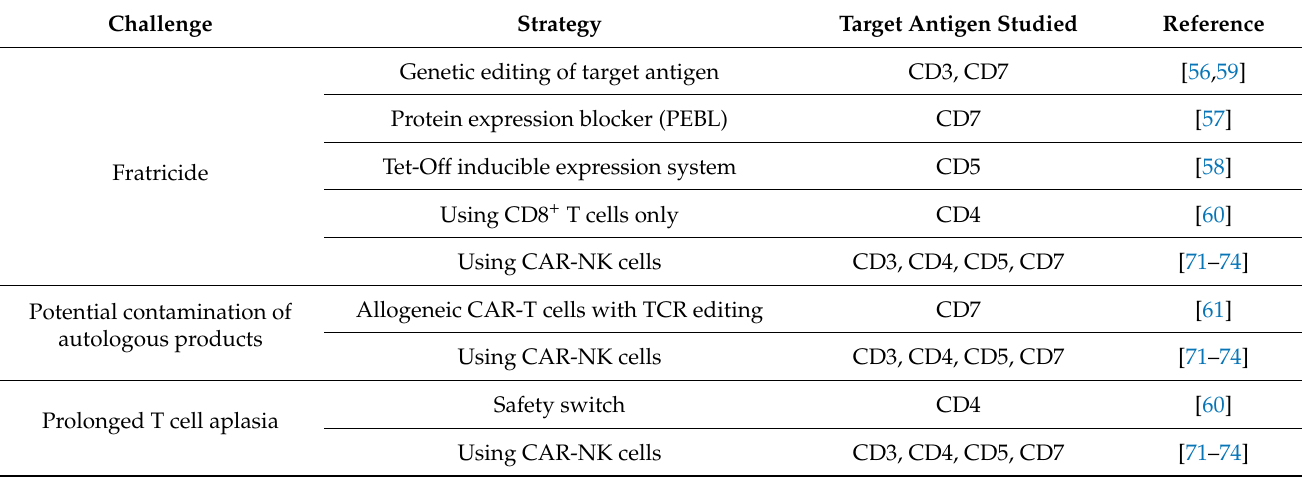
Table 4. Challenges of CAR-T therapy against T-ALL and strategies to overcome the